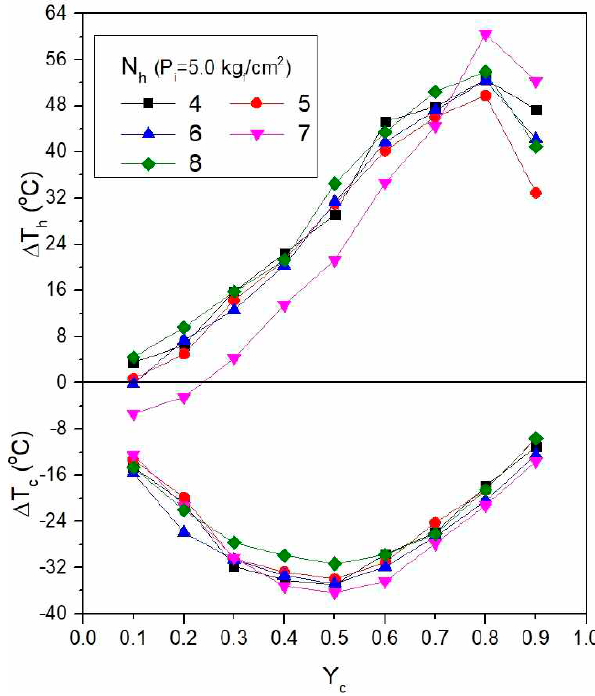
∆ T c according to inlet pressure (P i ) 5.0 kgf h and